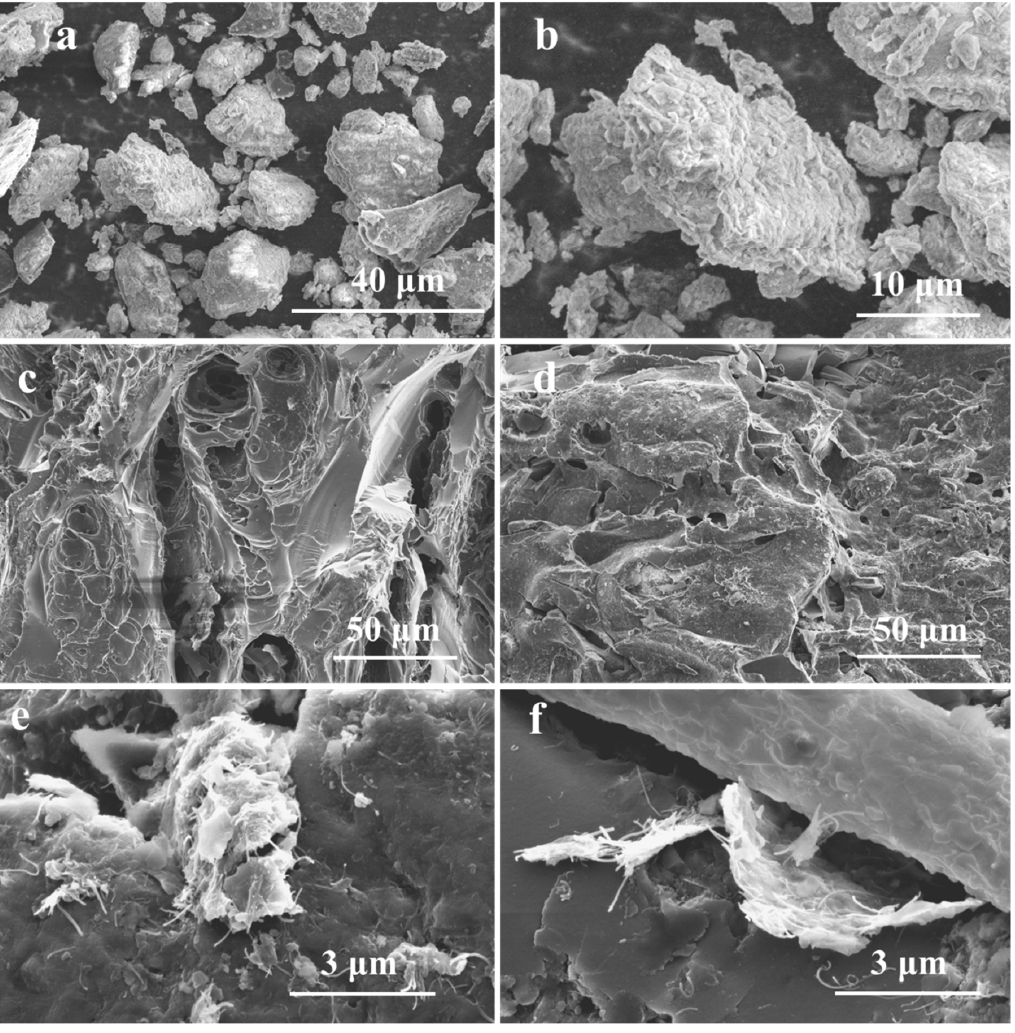
Figure 1. SEM images of AC under different magnifications ( a , b ), GO/AC composites ( c ), GO ‐ CNT/AC composites ( d ), high magnification images of GO ‐ CNT/AC composites ( e , f ).